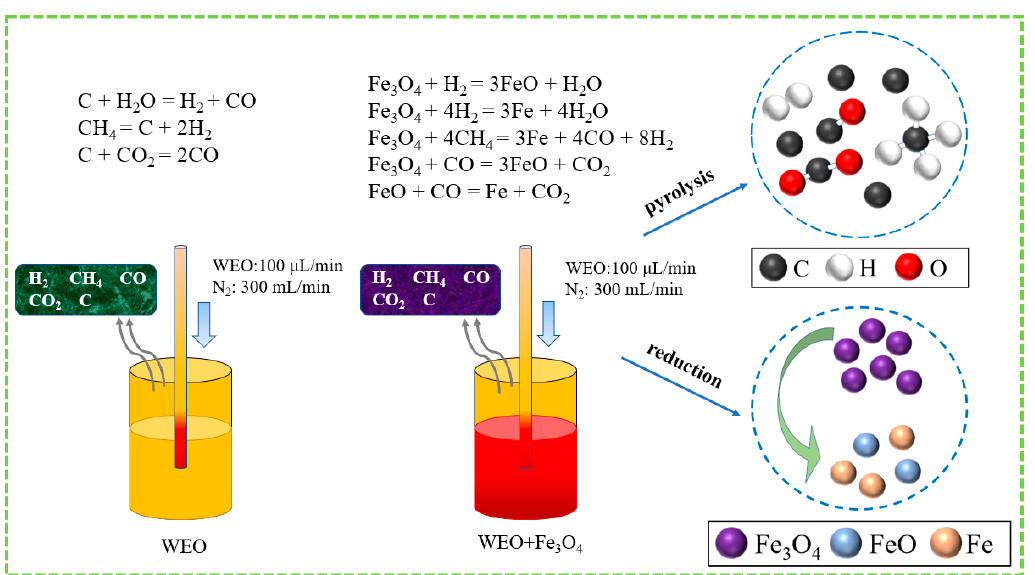
Figure 6. Reaction mechanism of WEO cracking.